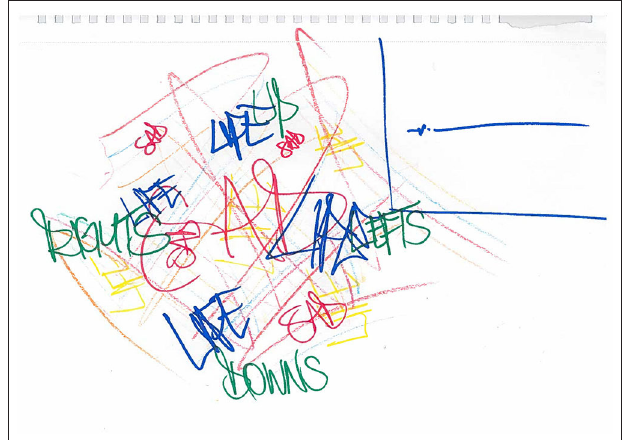
FIGURE 4 | WQ11 drawing of mixed emotions and emotions experienced before suicide/violence.